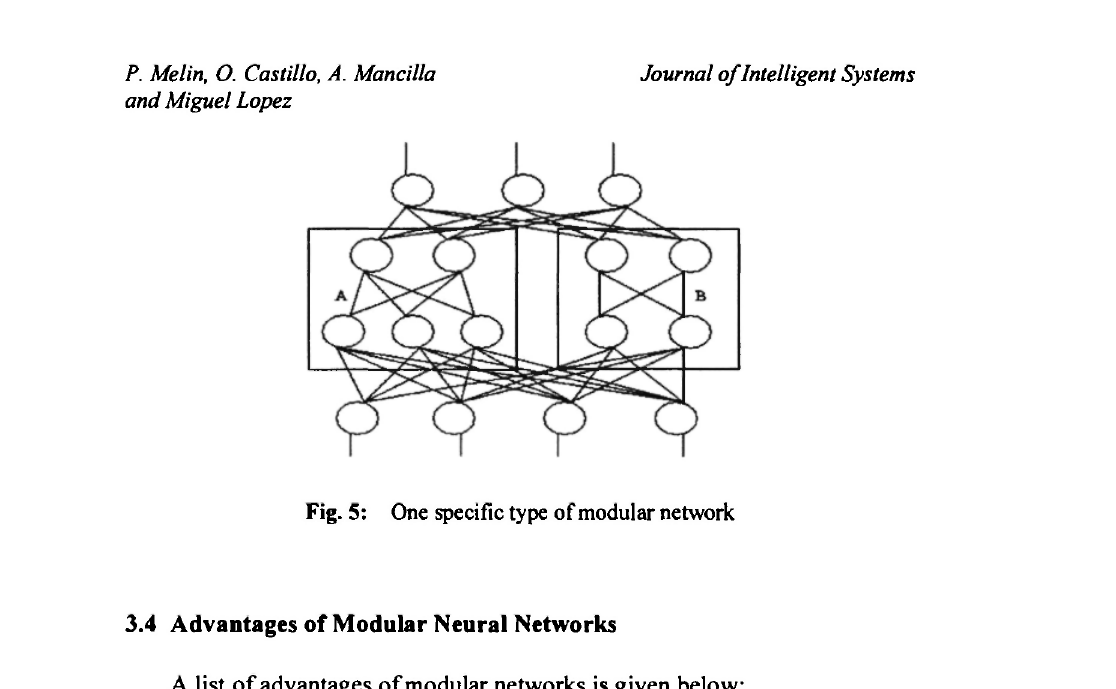
Fig. 5: One specific type of modular